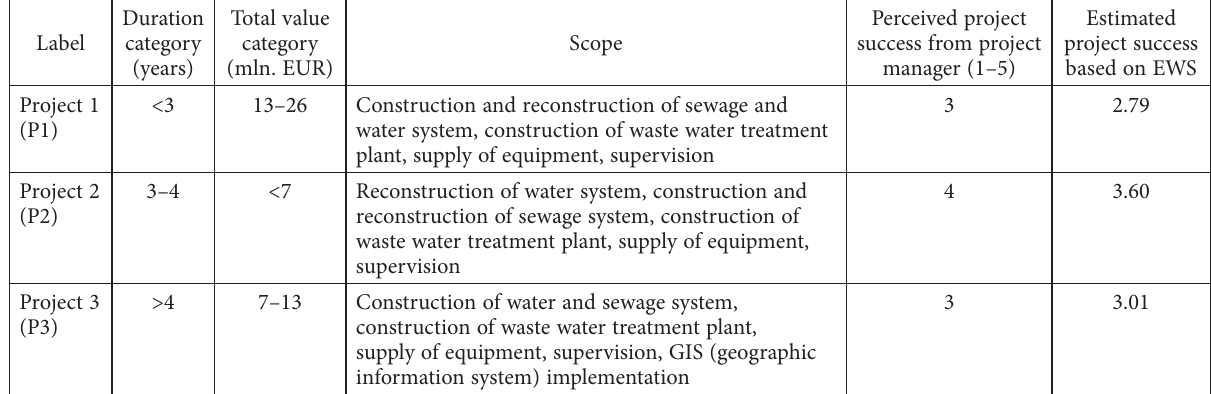
Table 5. Information of projects tested, and results of implementation attached to